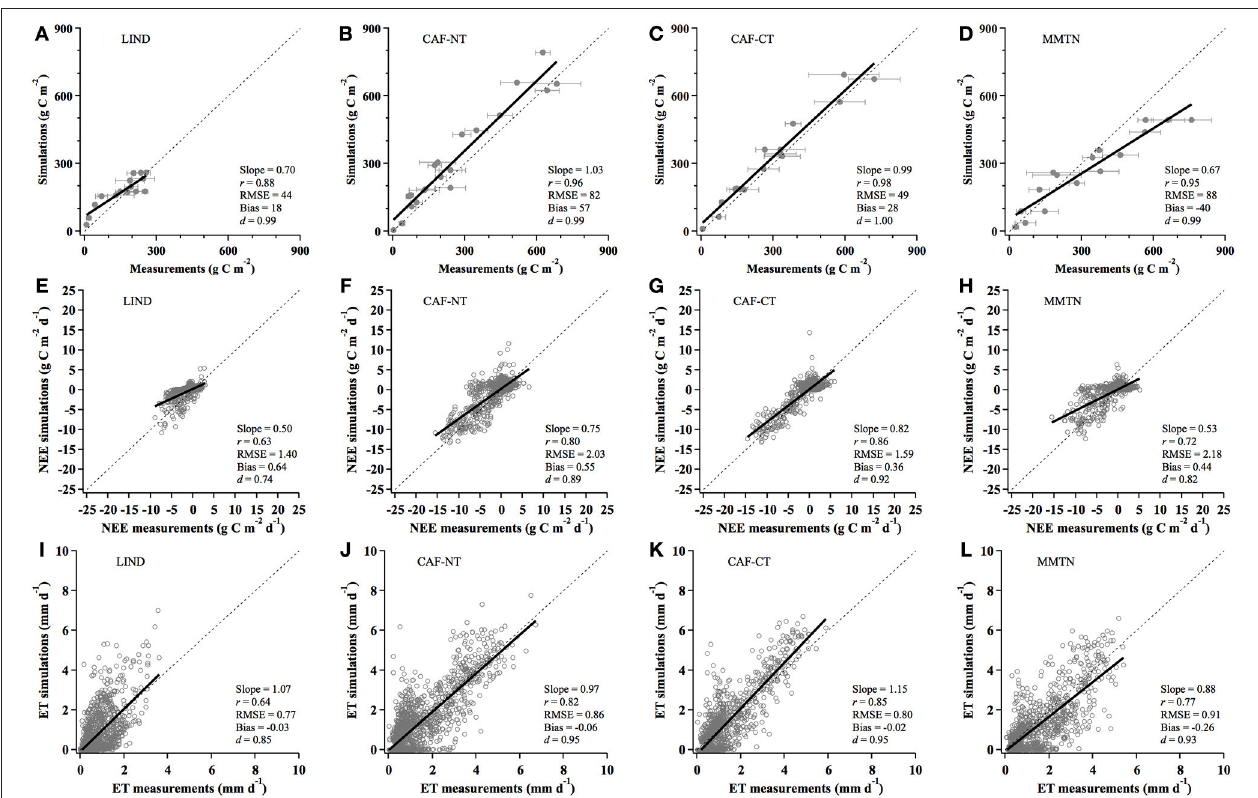
FIGURE 1 | Scatter plots of the simulated and the measured cumulative above-ground biomass (A–D), daily net ecosystem exchange of CO 2 (NEE, E–H ), and daily evapotranspiration (ET, I–L ) at four